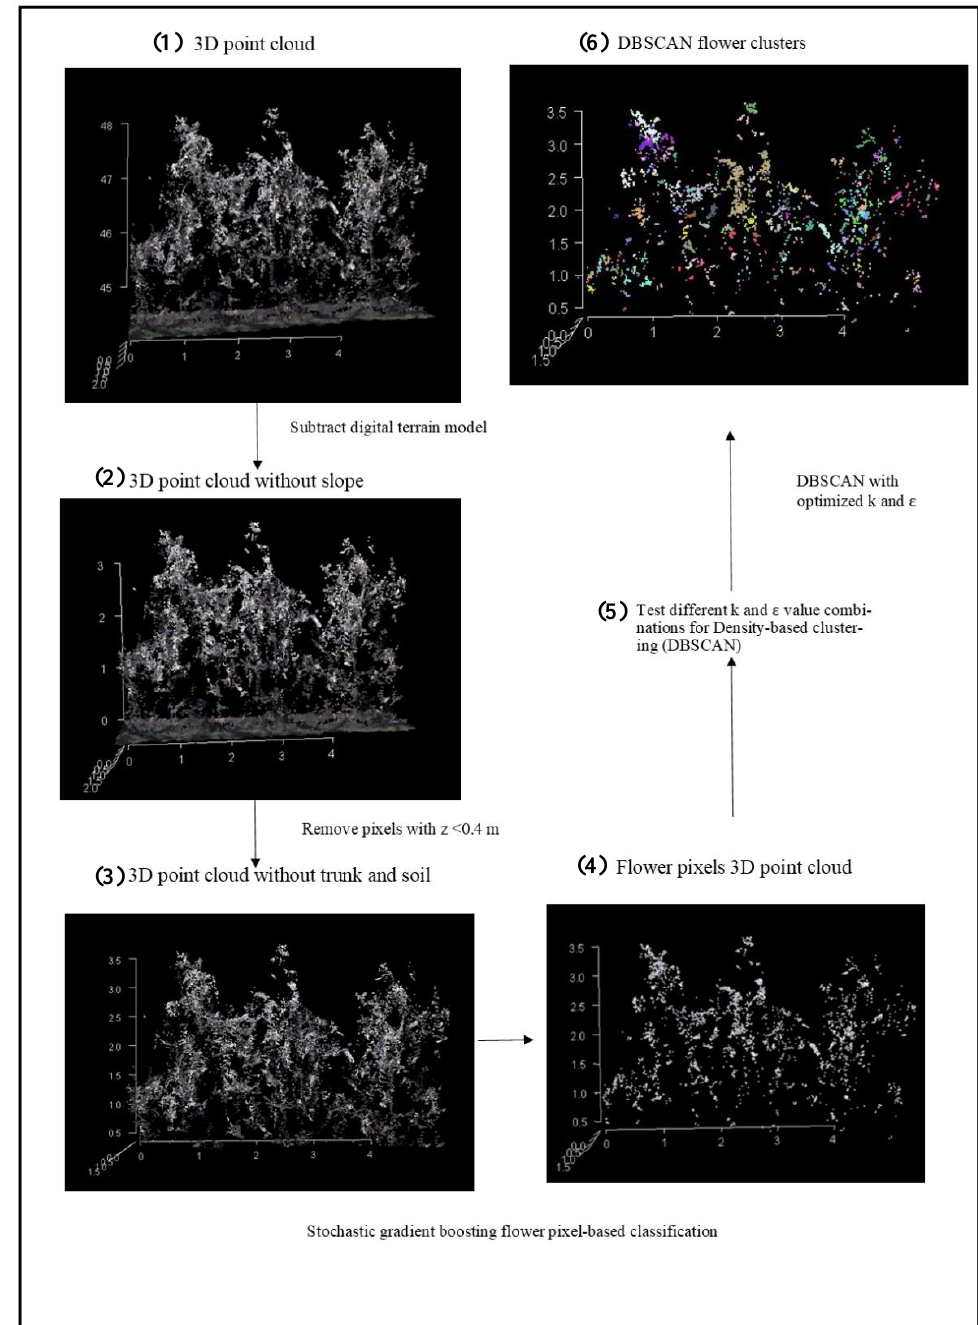
Figure 2. Overall flowchart of the flower cluster classification algorithm based on the colored dense point cloud, demonstrating the output of each step for plot 1B of Wimmertingen: (1) generate colored dense point cloud, (2) subtract DTM from dense point cloud, (3) remove soil and background pixels from dense point cloud, (4) perform stochastic gradient boosting flower pixel-based classification, (5) optimize DBSCAN parameters k and ε , (6) perform DBSCAN with optimal k and ε.